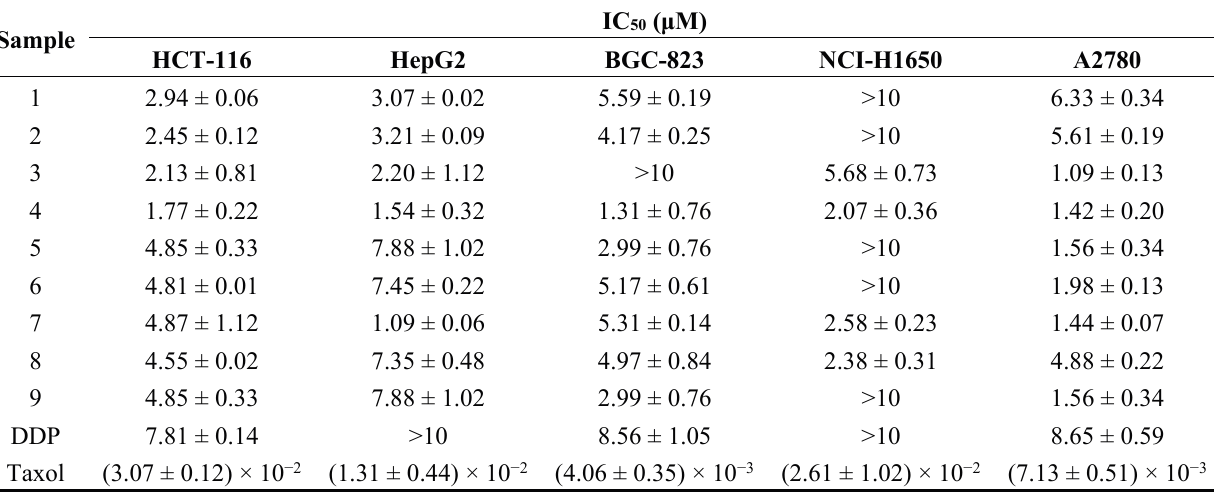
Table 2. Cytotoxic activities of all tested compounds on five human cancer cell lines.